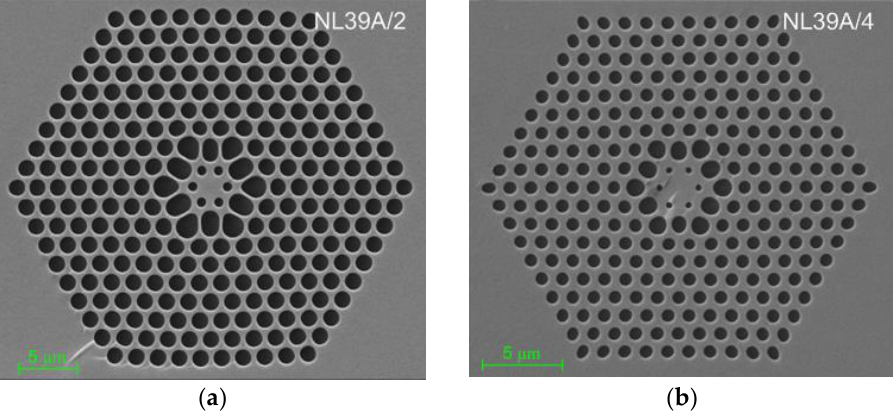
Figure 9. SEM images of the cross-sections of the developed fibers ( a ) #A2 and ( b ) #A4.